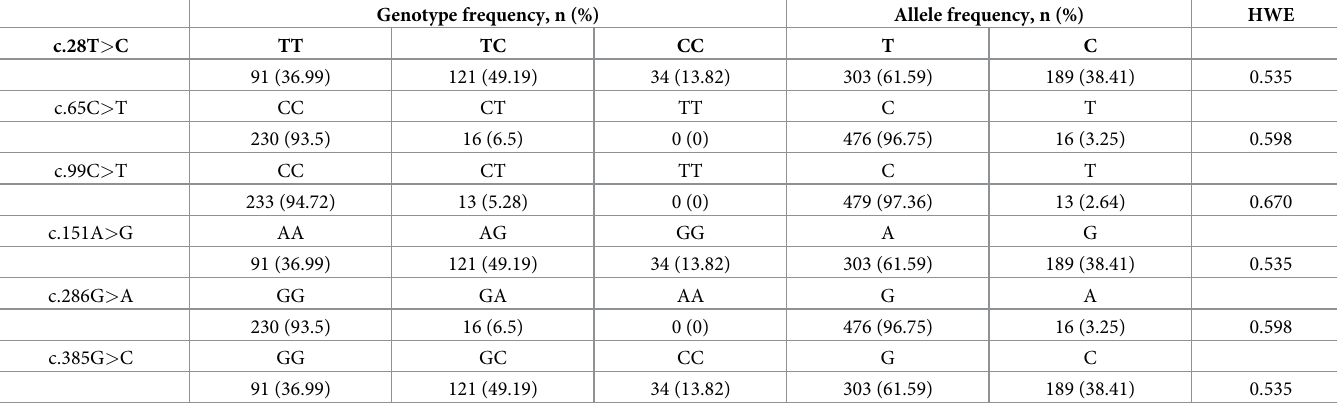
Table 1. Genotype and allele frequencies of PRND polymorphisms in Korean native black goats. Genotype frequency, n (%) Allele frequency, n (%)